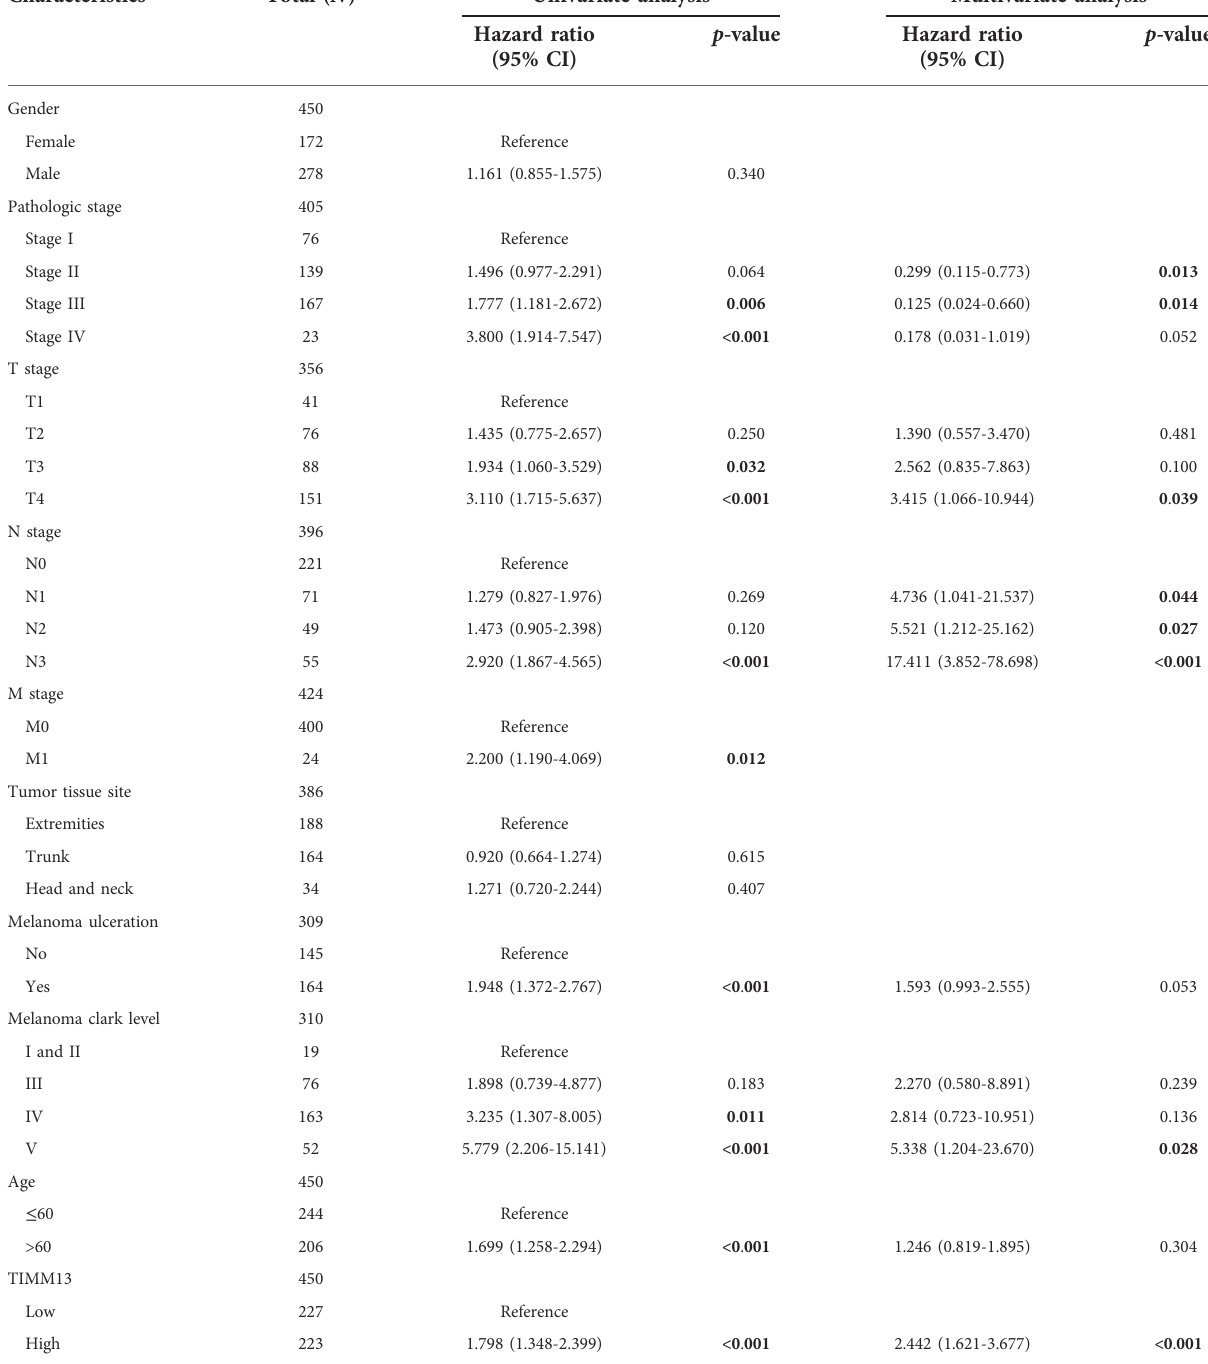
TABLE 2 Univariate and multivariate Cox regression analysis of